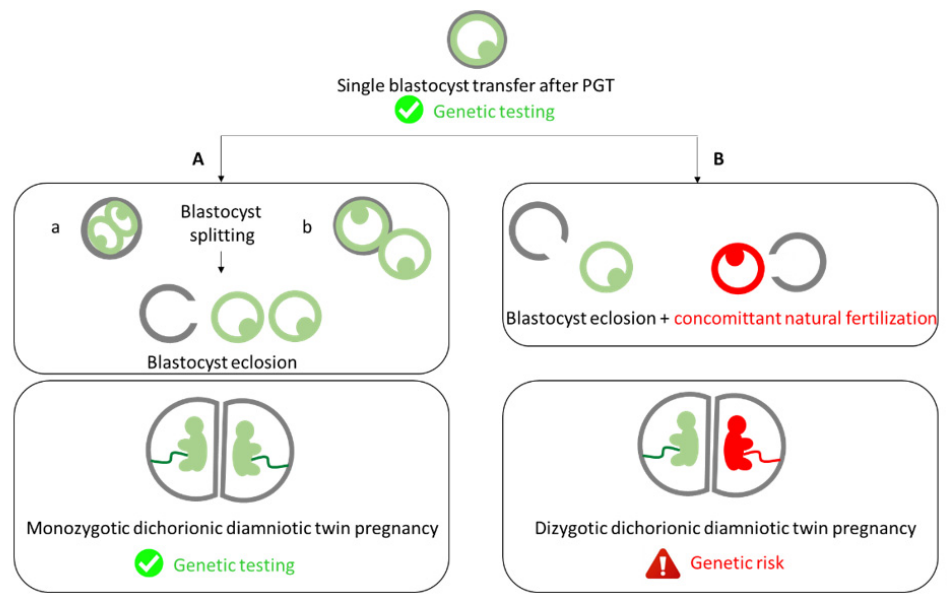
Figure 1. Schematic representation of the embryonic mechanisms that can lead to dichorionic diamniotic twin pregnancy. ( A ) Blastocyst splitting (a) before or (b) after (the “8” shape) its transfer leading to a monozygotic dichorionic diamniotic twin pregnancy. ( B ) Blastocyst transfer and concurrent spontaneous pregnancy leading to a dizygotic dichorionic diamniotic twin pregnancy.